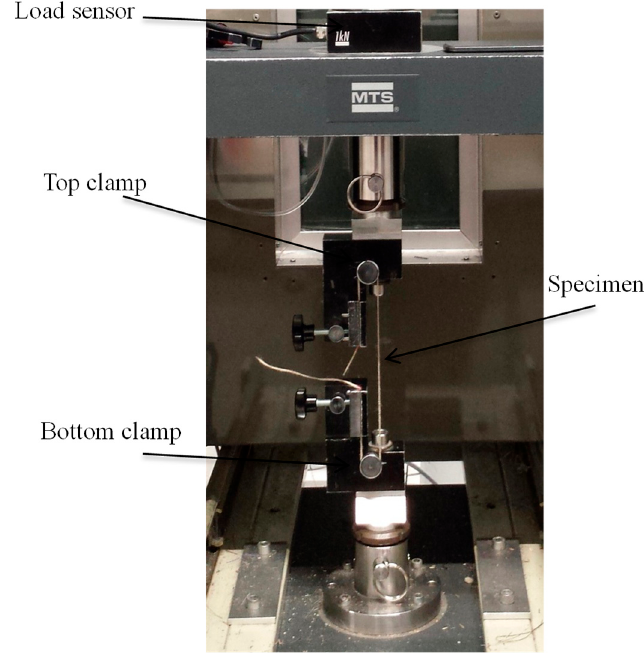
Figure 2. Set-up of the tensile machine with a single yarn specimen at ambient temperature.